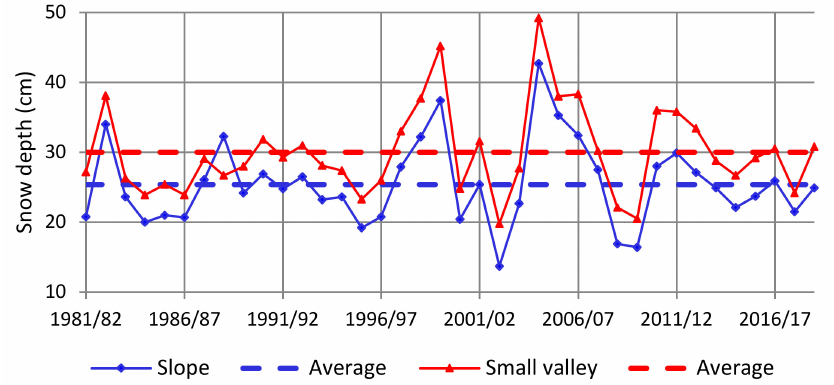
Figure 7. Long-term variability of the mean winter snow depth in the slope and shallow-valley types of terrain at the Chabyda station (dashed and dotted lines are long-term average